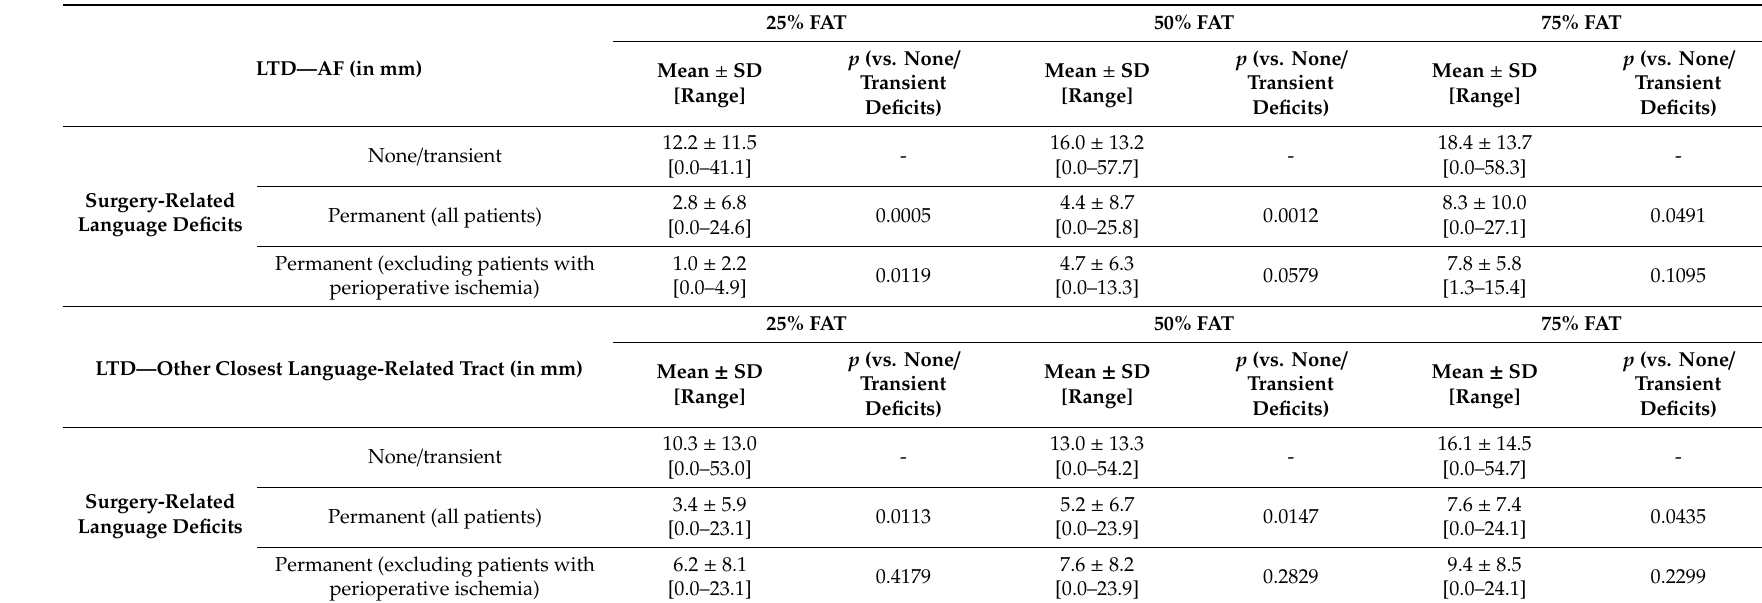
Table 4. Lesion-to-tract distances (LTDs) for surgery-related language